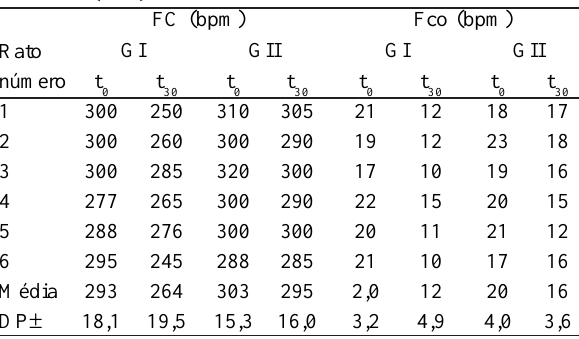
Tabela 1. Variações da frequência cardíaca (FC) e fluxo coronário